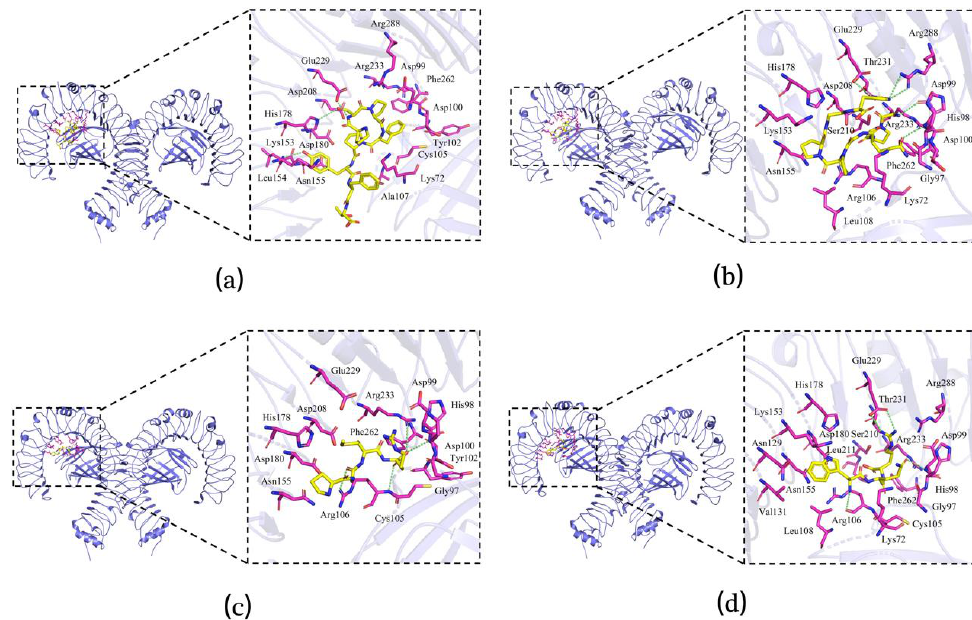
Figure 7. Binding and interacting residues of peptides with TLR4/MD-2 (ID: 5IJD). PSPFPYFT- TLR4/MD-2 ( a ), GPQGPPGH-TLR4/MD-2 ( b ), PGMR-TLR4/MD-2 ( c ), and WQR-TLR4/MD-2 ( d ). In the figure, green represents hydrogen bonds, yellow represents polypeptide ligands, and purple represents amino acid residues related to the